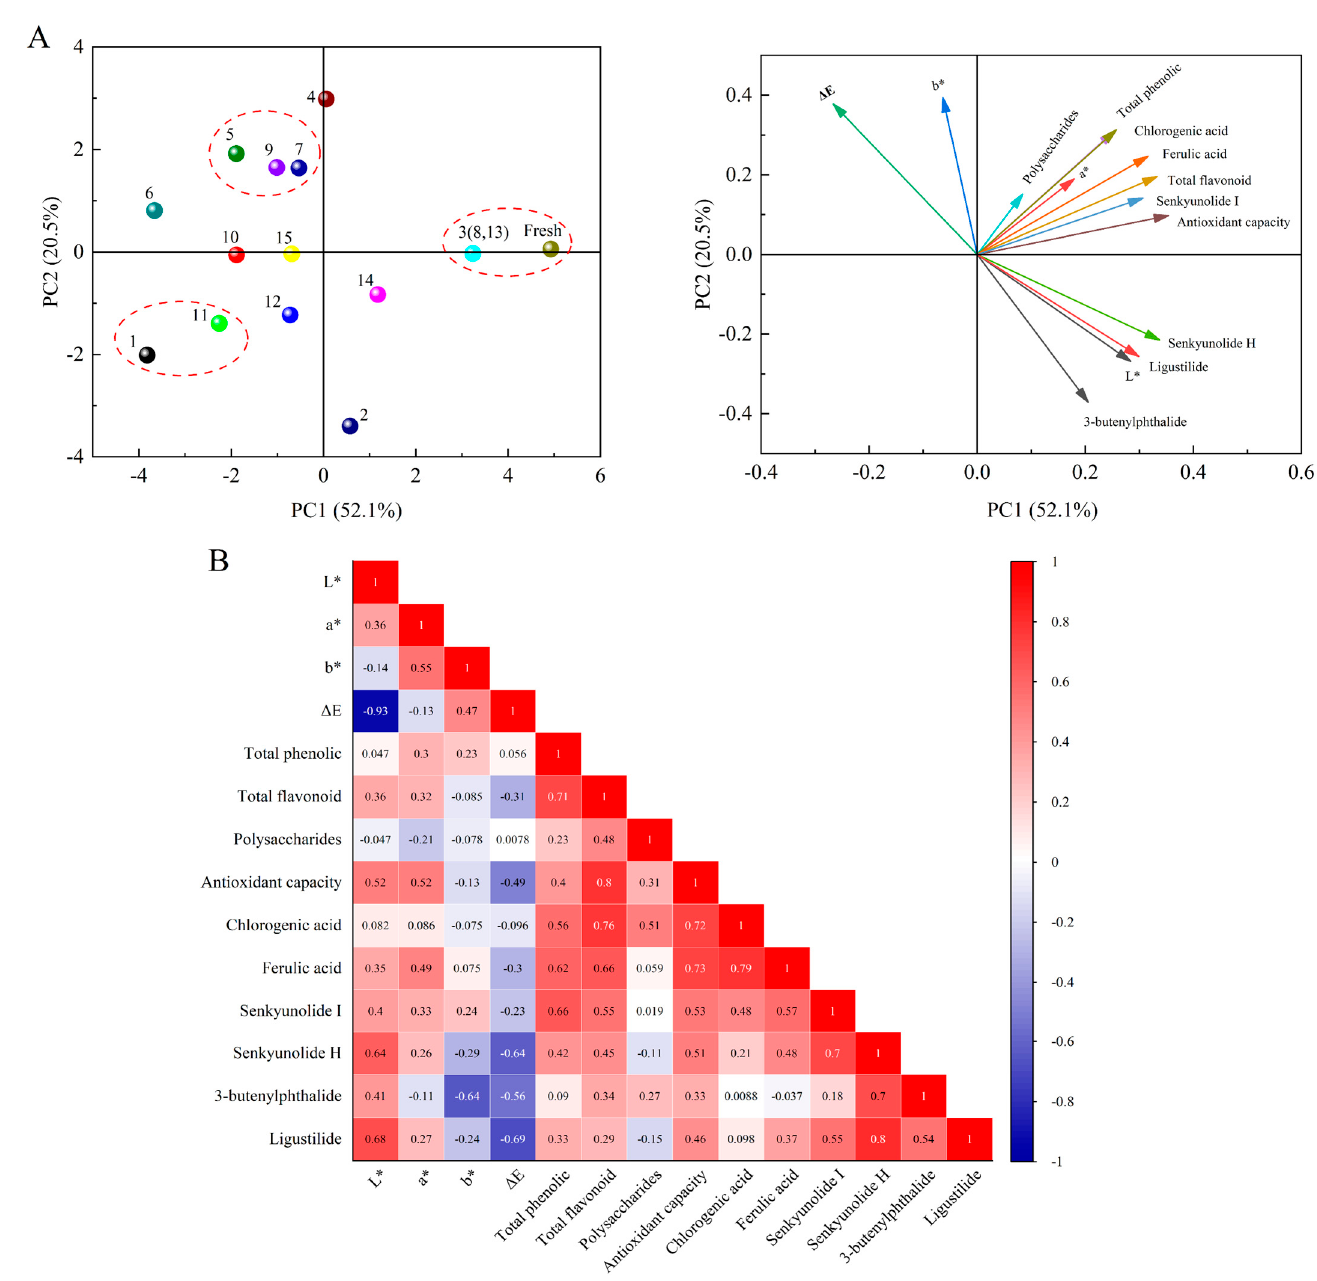
Figure 10. Principal component analysis ( A ) and Pearson correlation analysis ( B ) plot of physico- chemical quality obtained from different drying treatments.